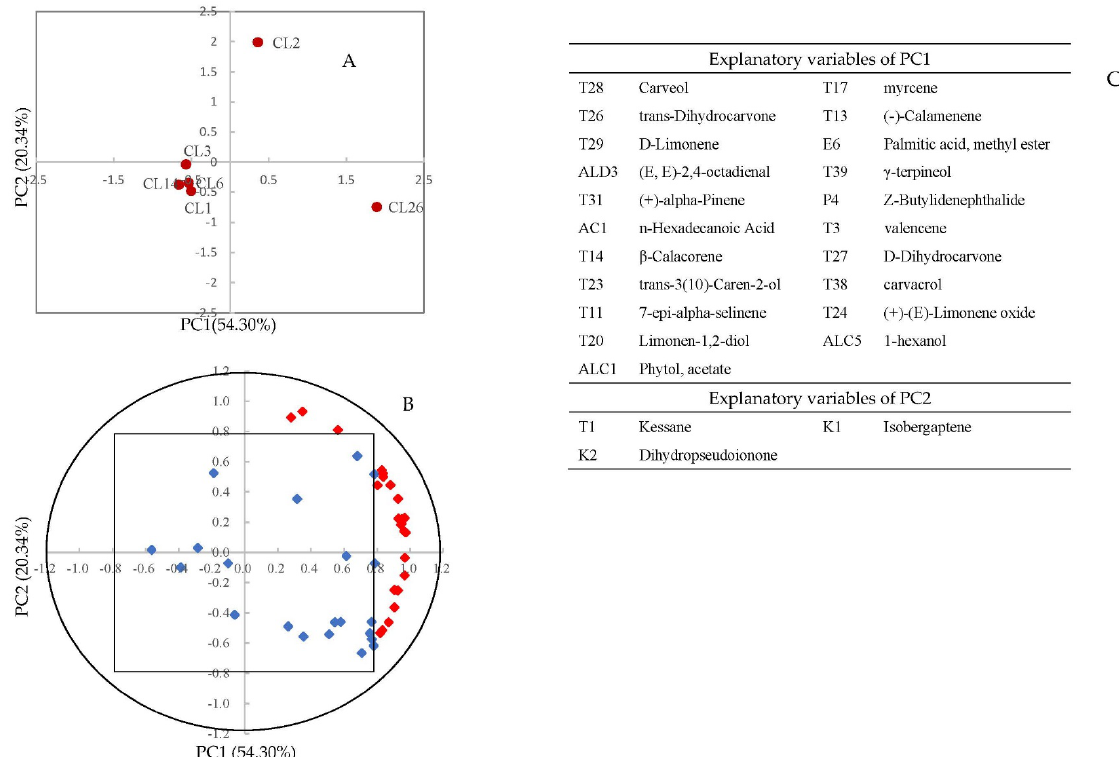
Figure 7. Principal component analysis of juice made from six celery cultivars (CL1, CL2, CL26, CL6, CL3, and CL14) using 45 differential volatile compounds as variables. ( A ) Projection of cultivars; ( B ) distribution of variables; ( C ) the explanatory variable (22 compounds) of PC1 and explanatory variable (three compounds) of PC2 (red diamond, load value > 0.8).